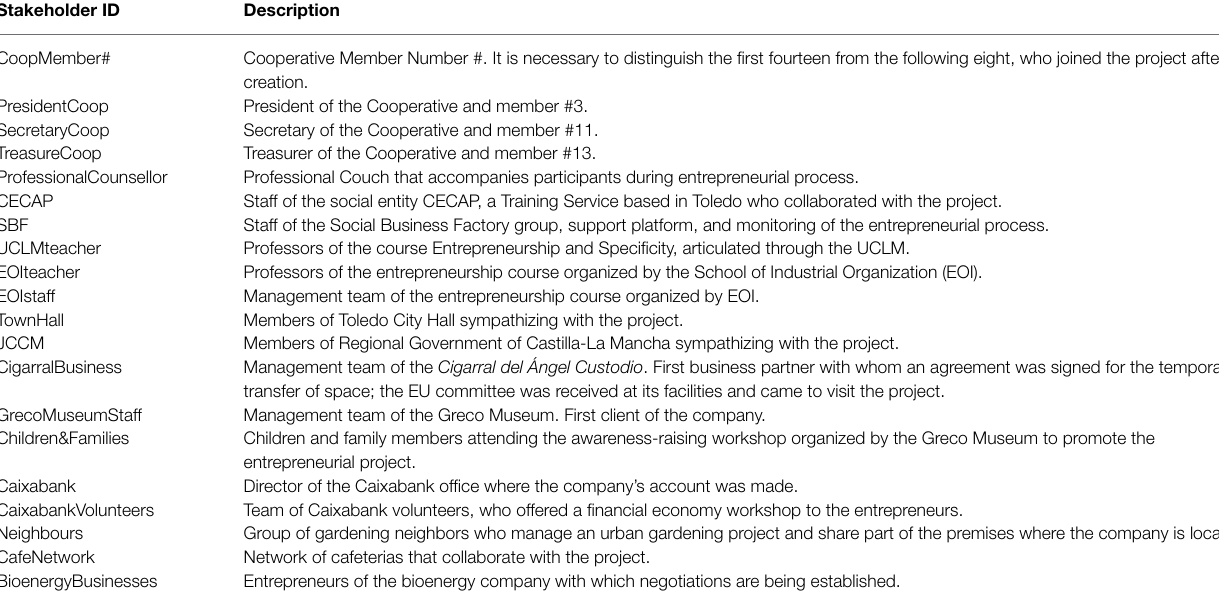
TABLE 2 | Stakeholders participating in the